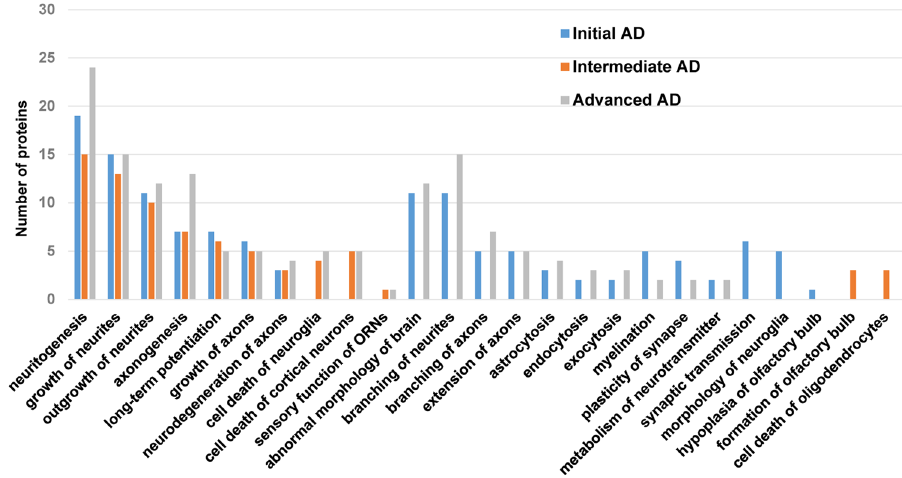
Figure 2. Functional metrics of the differential OB proteome across AD staging. Specific-neuronal pathway analysis for the differential OB proteomic expression profile detected in each AD stage is